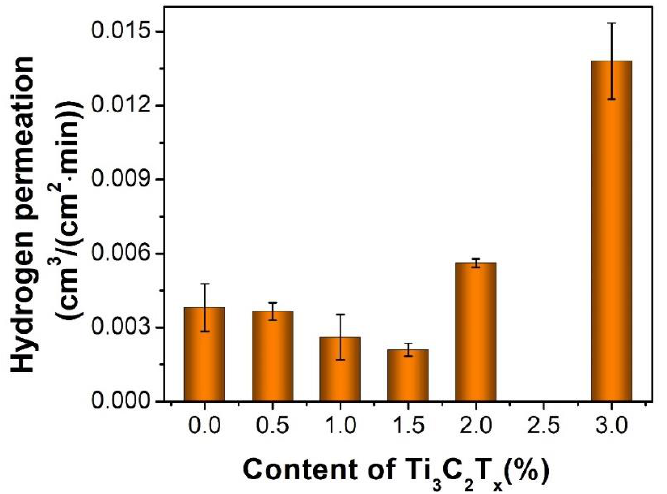
Figure 7. Hydrogen permeation of the membranes with different Ti 3 C 2 T x contents at room tem-